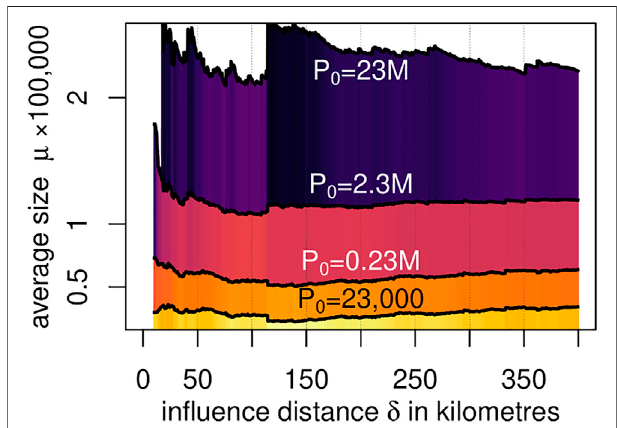
FIGURE 6 | Average city size (vertical axis) for different values of the in fl uence distance δ (horizontal axis) for acentre witha population of23 million inhabitants (nearly the population of Cairo, for example) in purple, and a city 10,100,and1000timessmaller(thepink,orange,andyellowpolygons). Thus, at a distance of50 km from acity withthe size ofCairo, for example, we expect cities to have an average size of roughly 300,000 inhabitants. However,atadistanceof50 kmfromasmallercity,forexample,acentrewith 2.3 million inhabitants, cities in the region of in fl uence will have, on average, 100,000